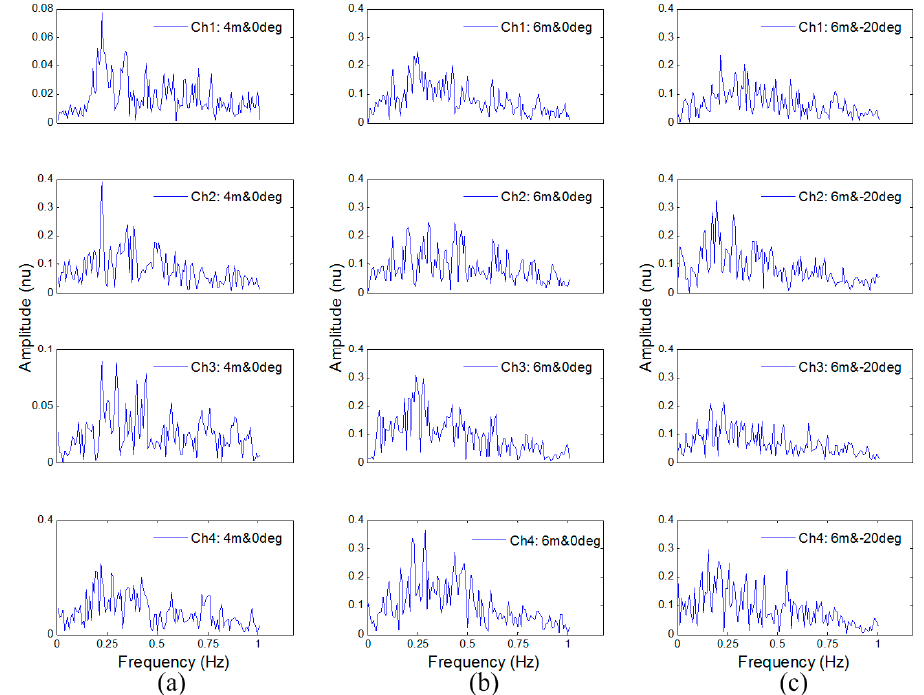
Figure 12. Results processed by the single-channel Kalman filtering: the volunteer was at the position (4 m, 0°) ( a ); the volunteer was at the position (6 m, 0°) ( b ); and the volunteer was at the position (6 m, − 20°) ( c ). The rows from top to bottom corresponds to channel 1, 2, 3 and 4, respectively.